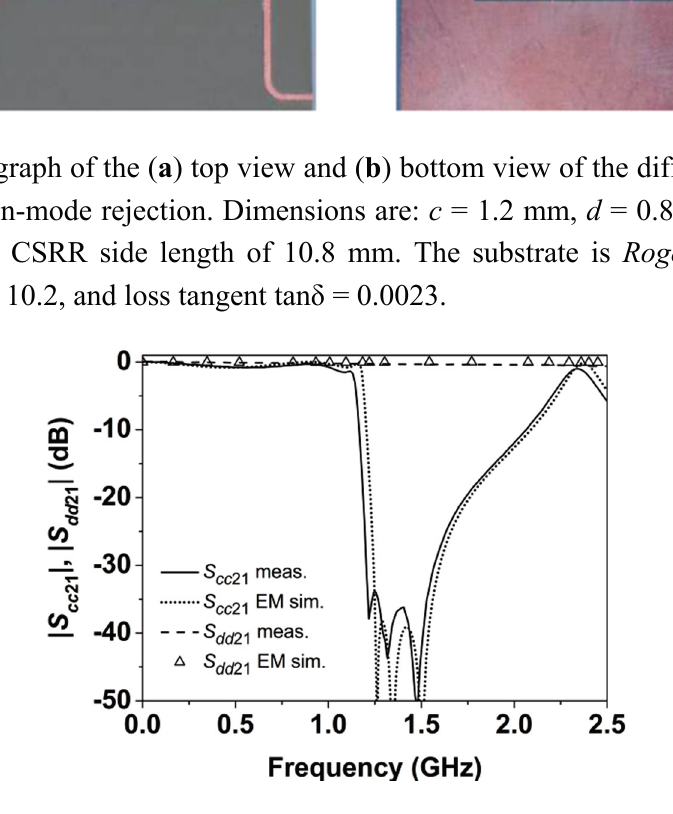
Figure 18. Common-mode and differential-mode insertion loss | S cc 21 | and | S dd 21 | for the structure of Figure 17. From [36]; reprinted with permission from IEEE